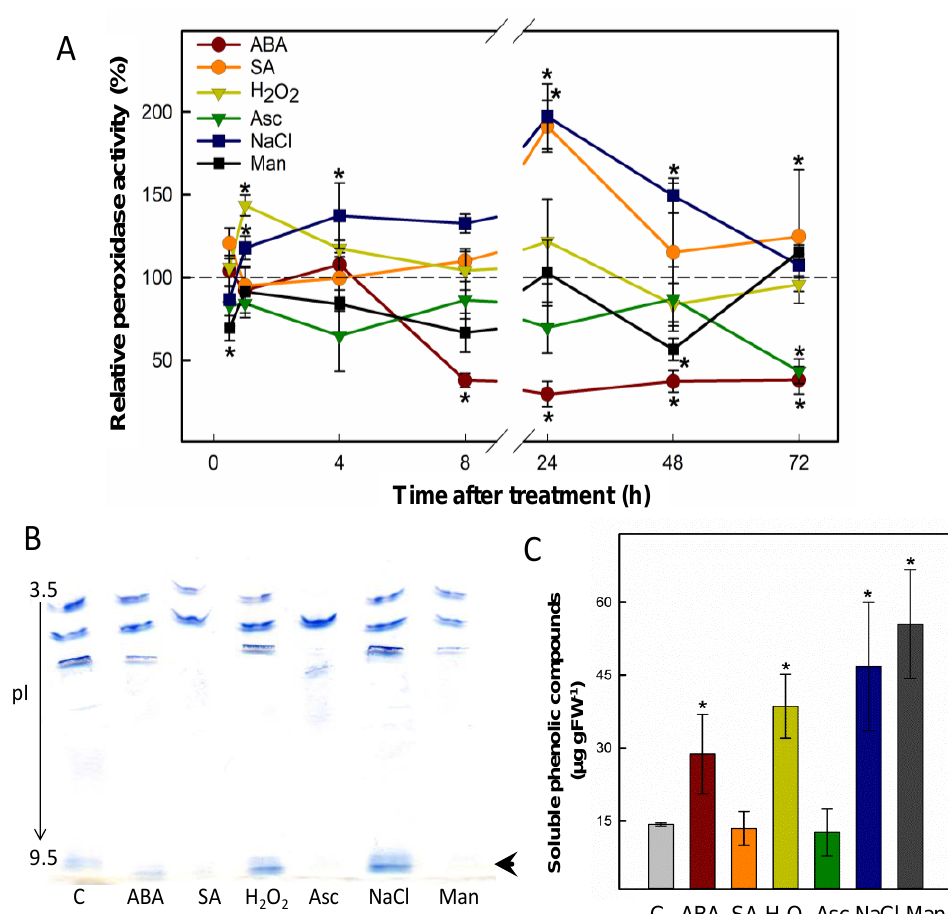
Figure 1. Salt and oxidative stress upregulate the expression of a basic peroxidase from P. patens . ( A ) Time-course determination of peroxidase activity extracted from P. patens gametophores that were subjected to different stress treatments: H 2 O 2 with or without ascorbic acid (Asc), salt, mannitol (Man), abscisic acid (ABA) and salicylic acid (SA). TMB was used as substrate and peroxidase activity was normalized to control conditions at each time point (shown as a dashed line). ( B ) Effect at 24 h of different treatments on peroxidase isoenzyme pattern revealed by IEF stained with 4-MN. C, control; pI, isoelectric point. ( C ) Effect of stress treatments at 96 h on soluble phenolic content in P. patens cultures. Data presented are average values ± SD of n = 3 experiments. Statistical analysis was carried out with Duncan ’s test, asterisks represent statistical differences from control ( p < 0.05).